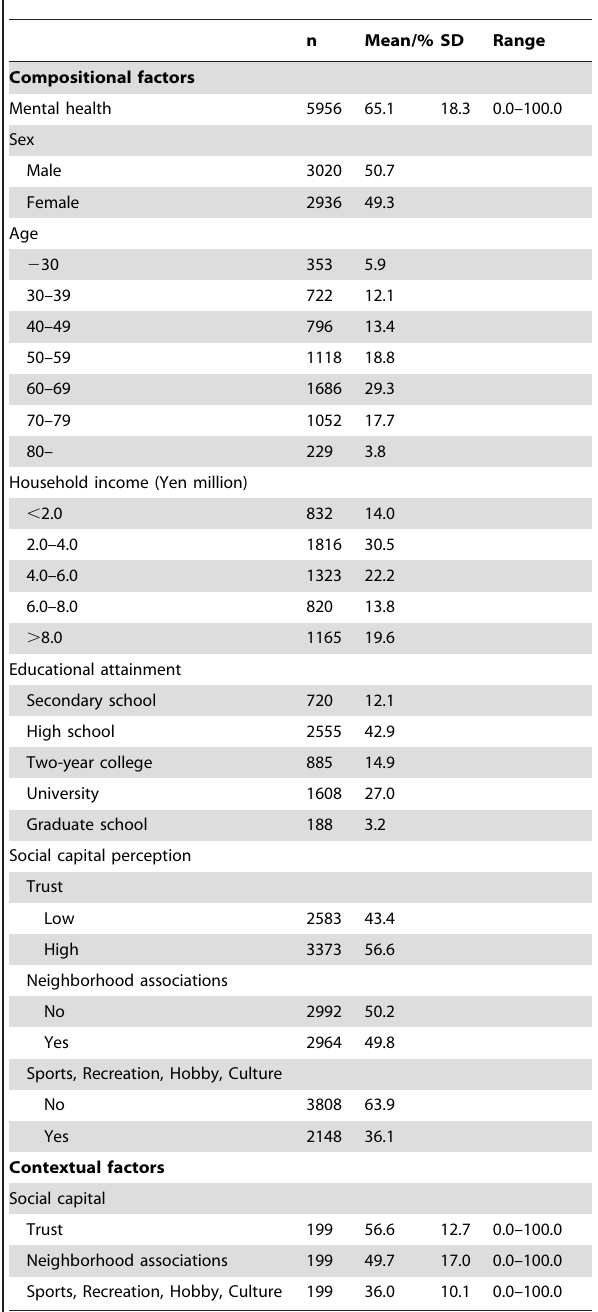
Table 1. Descriptive statistics for compositional and contextual variables used in